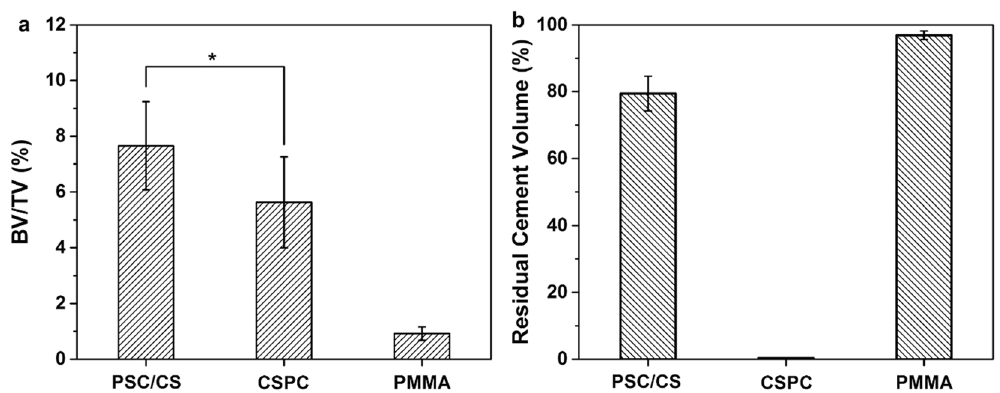
Figure 5. Quantitative analysis of new bone formation and residual cement from micro-CT images. * Indicates significant differences between the groups connected with the line (P <